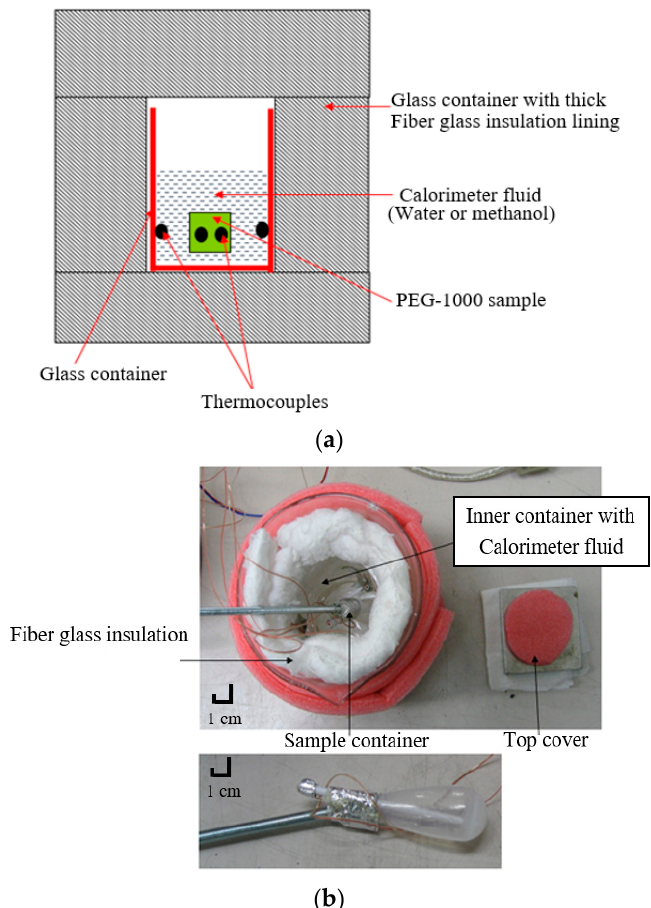
Figure 6. Calorimetry experimental method for measuring the PCM specific heat in solid state. ( a ) Cross sectional details of test set-up; ( b ) Component details of set-up.